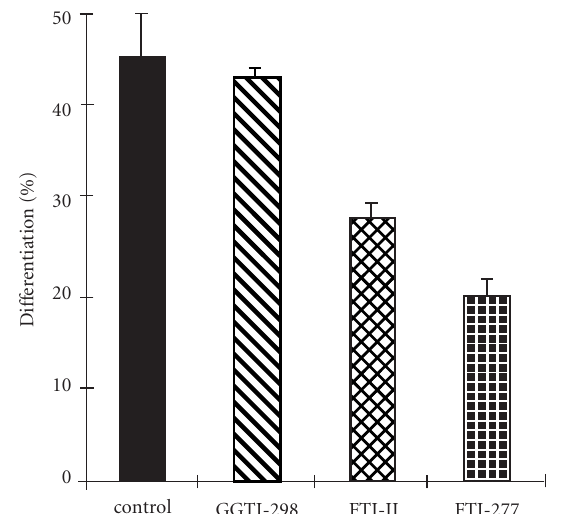
Figure 4: Effect of prenylation protein inhibitor on differentiation of HL-60 cells by ATRA. HL-60 cells were pretreated with 10µM of GGTI-298 or FTI-II or FTI-277. After 24hours, The ATRA (1µM) was added to culture medium. Cell differentiation was determined at day 4.